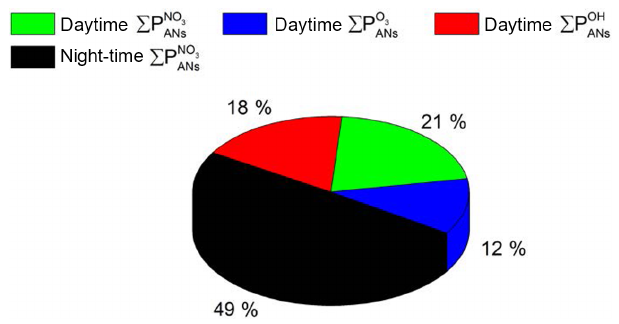
Figure 5. Contribution of NO 3 -, OH- and O 3 -initiated degradation of VOCs to the overall formation of alkyl nitrates.